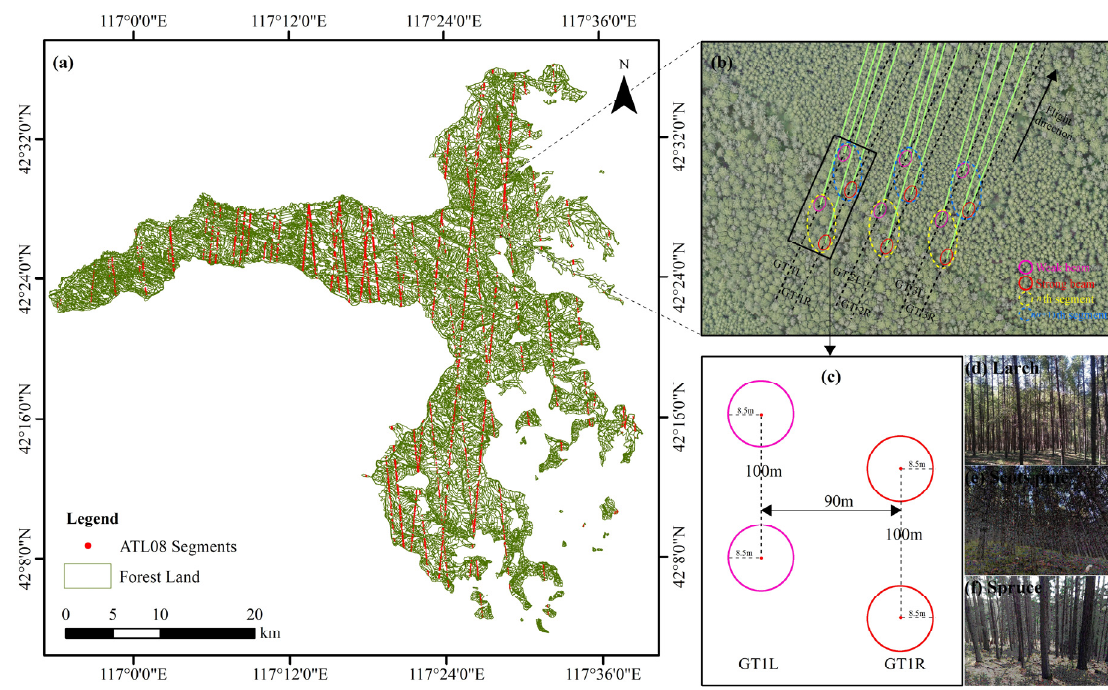
Figure 3. ( a ) ATL08 segments covering Saihanba forest farm; ( b ) the schematic of the ATL08 data; ( c ) the detailed parameters in the ATL08 segments; ( d ) larch; ( e ) Scots pine; ( f ) spruce. Table 3. The 98% vegetation canopy height obtained from the ATL08 data in the Saihanba forest farm.